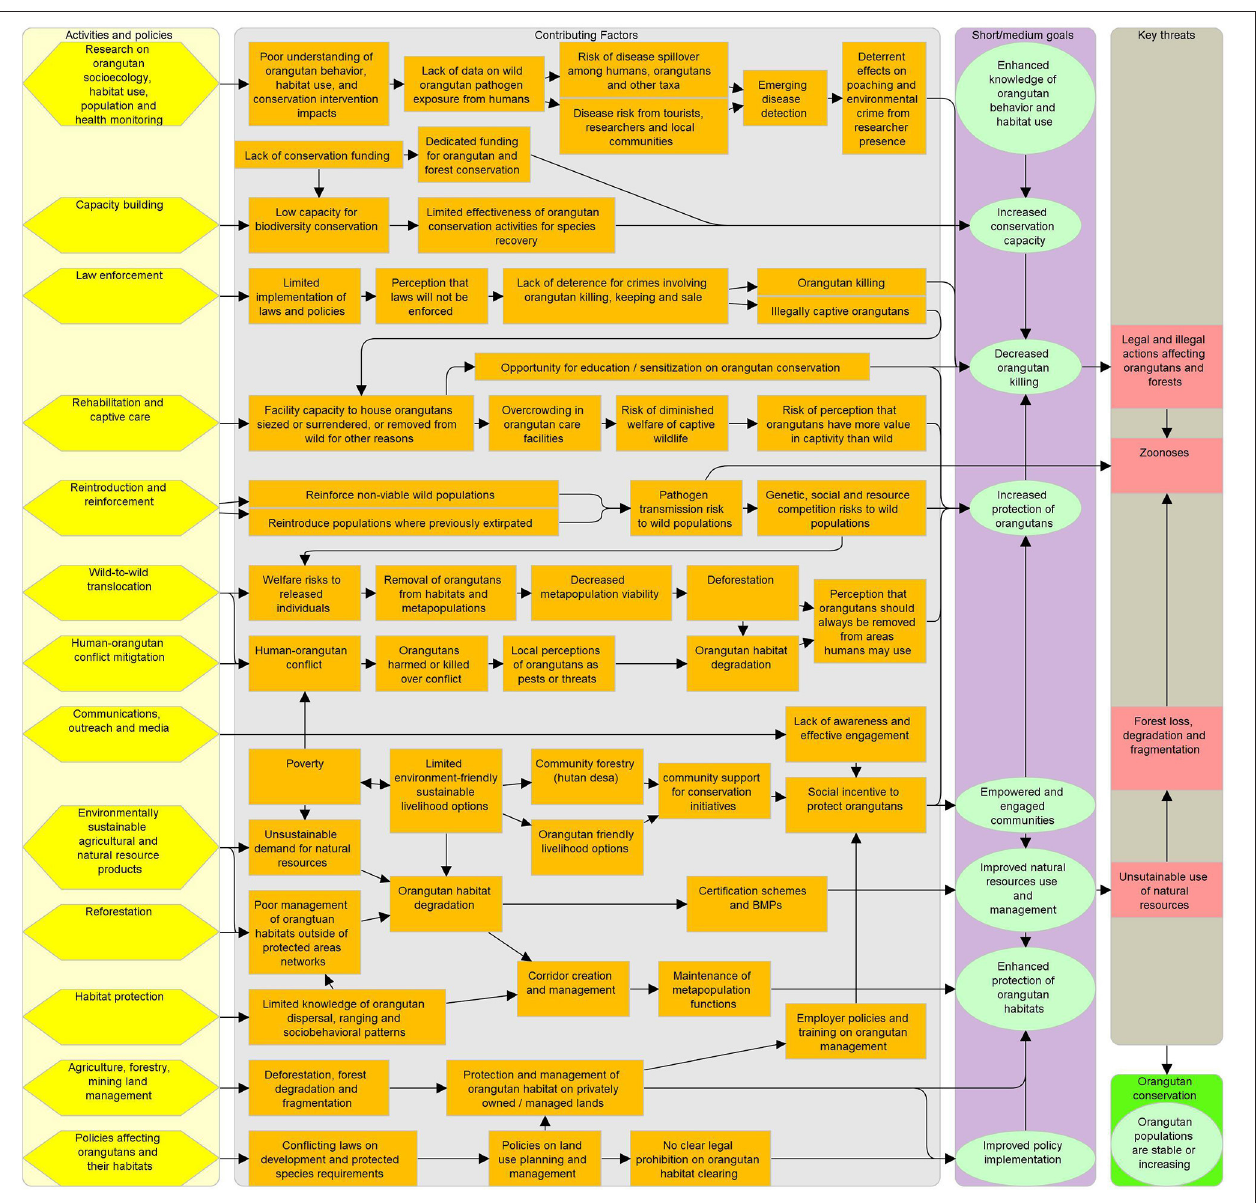
FIGURE 5 | Orangutan conservation complexity. Cells in far left column are activities and policies affecting orangutans. Central section cells describe positive and negative factors that affect orangutan conservation outcomes. The second column from the right shows the interim goals of activities and policies. Key threats that activities and policies aim to address are in the far right column. Arrows indicate relationships between